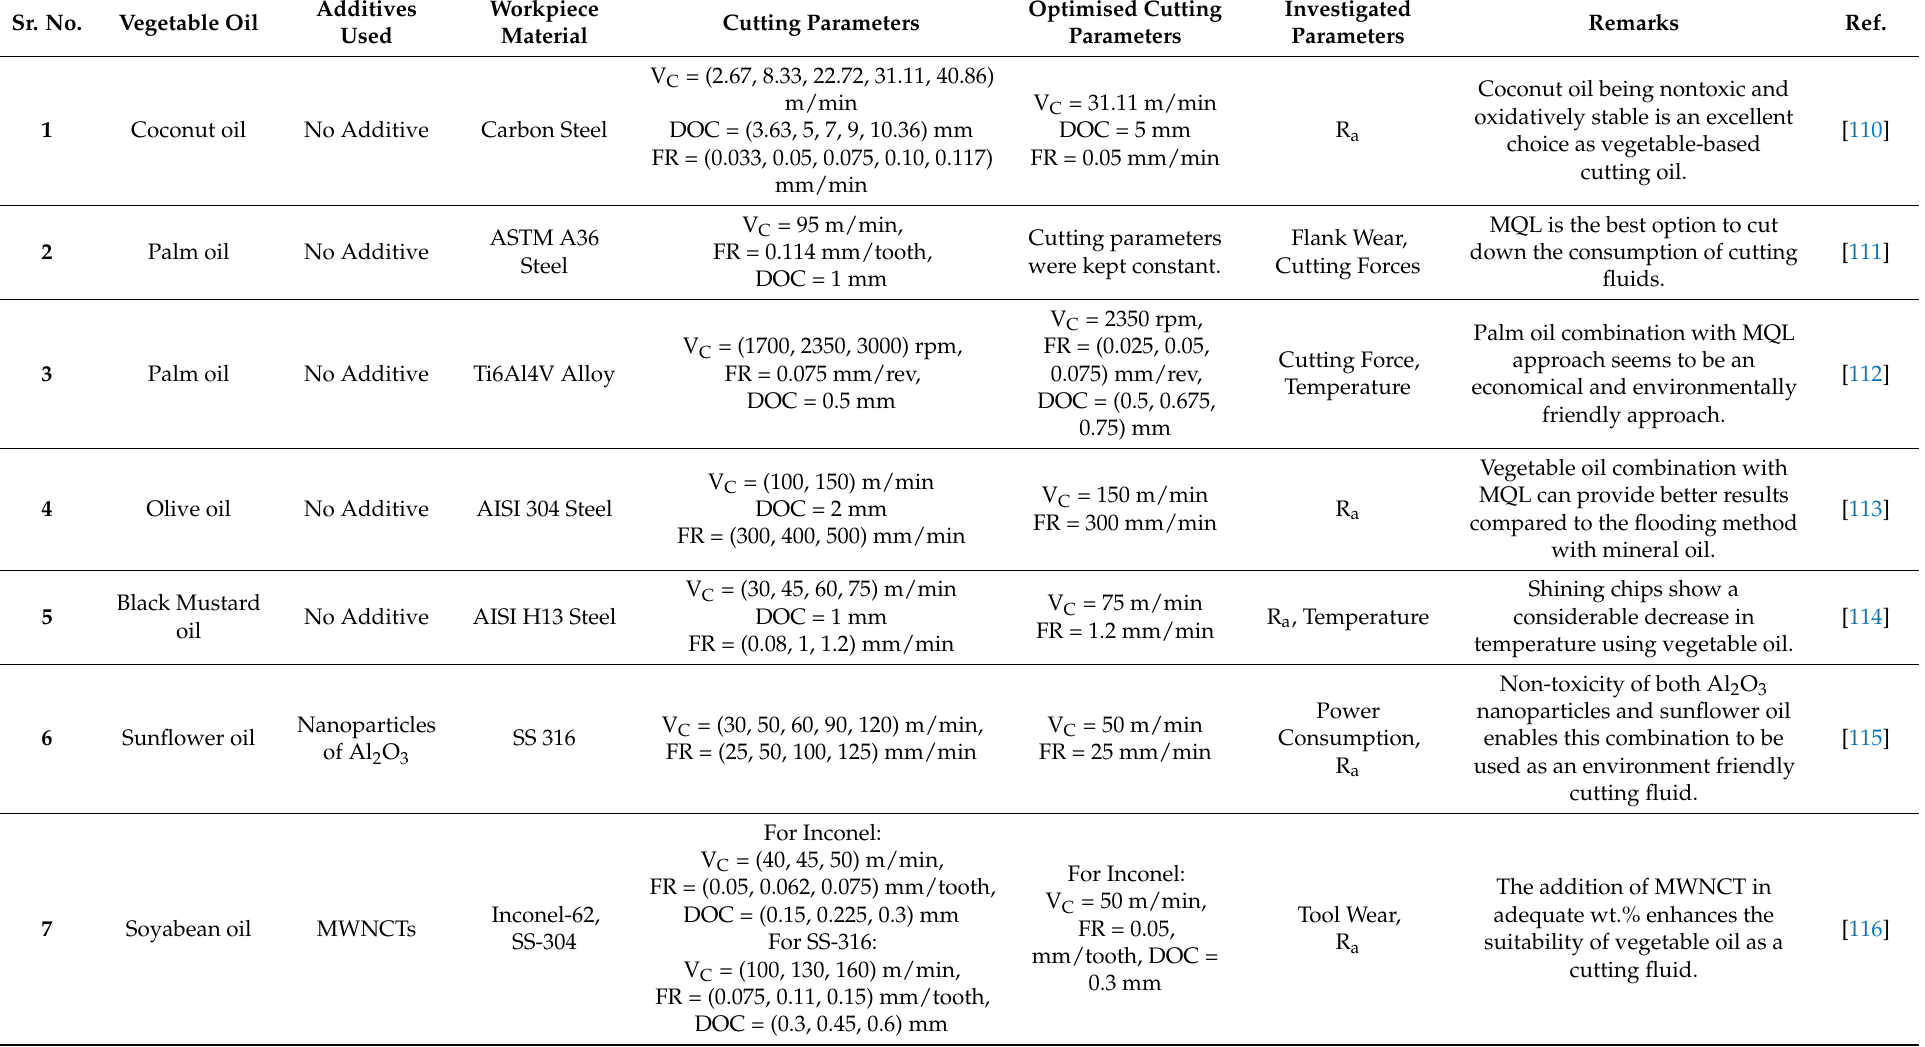
Table 5. Milling Operation Using Edible Vegetable Oil-Based Cutting